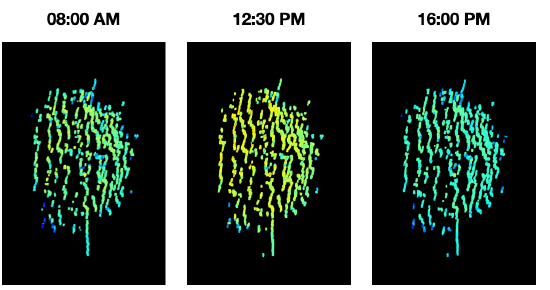
Figure 20. 4D phenotyping models of the Guaiacum plant in the three hours of the day where it had the lowest and highest peaks.